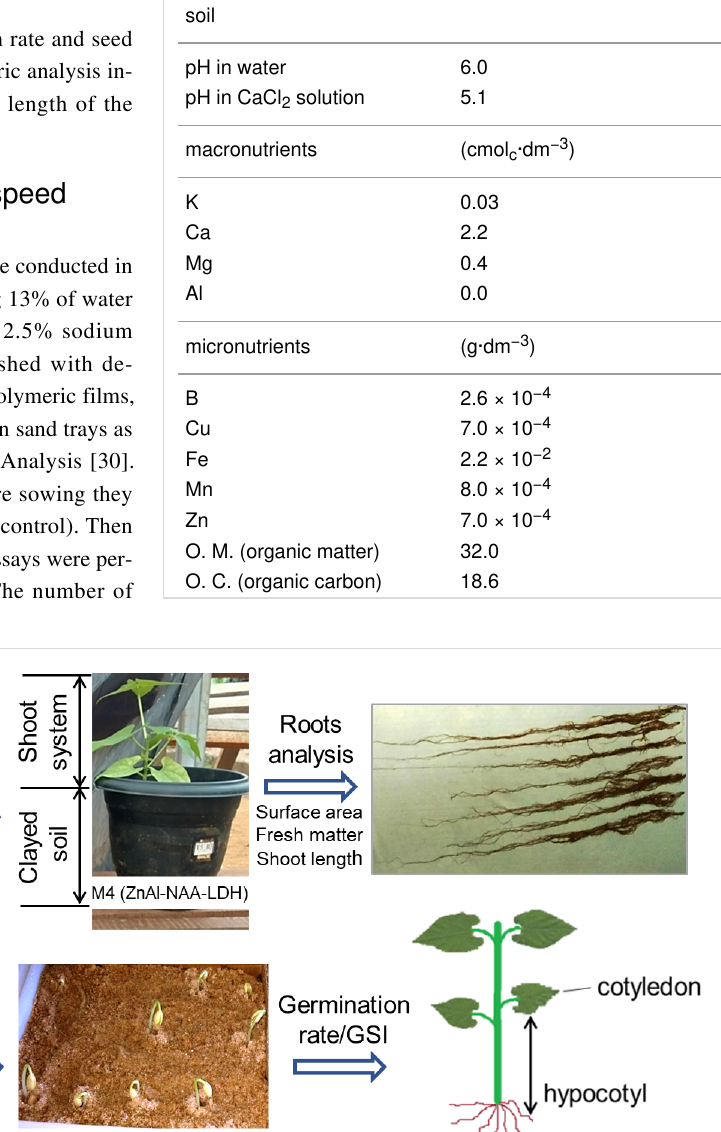
Table 2: pH values, macronutrients, micronutrients, organic matter and organic carbon contents of the soil used in the